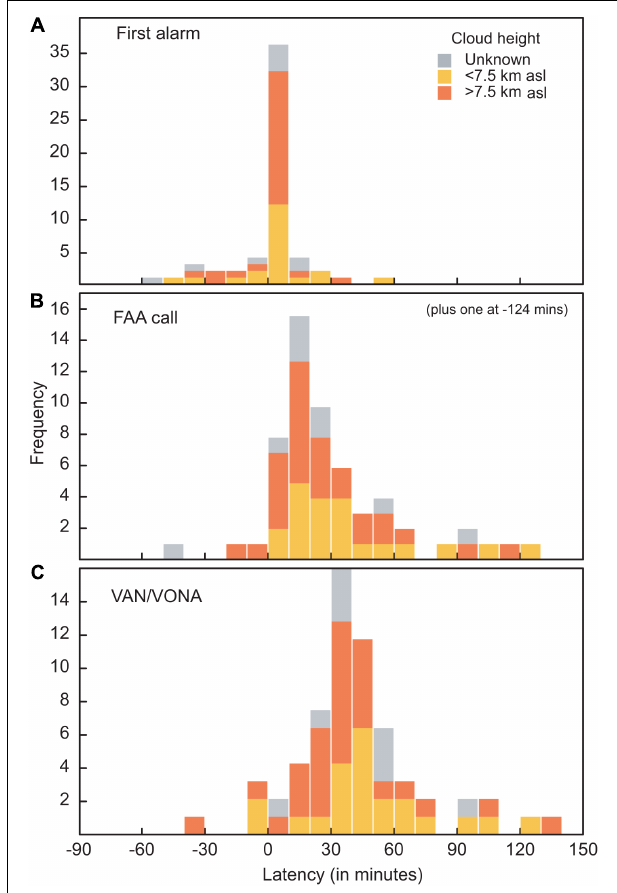
FIGURE 7 | Histograms of latency of (A) first alarm, (B) , call to FAA, and (C) VAN issued, for explosive events during the 2016–2017 eruption of Bogoslof.